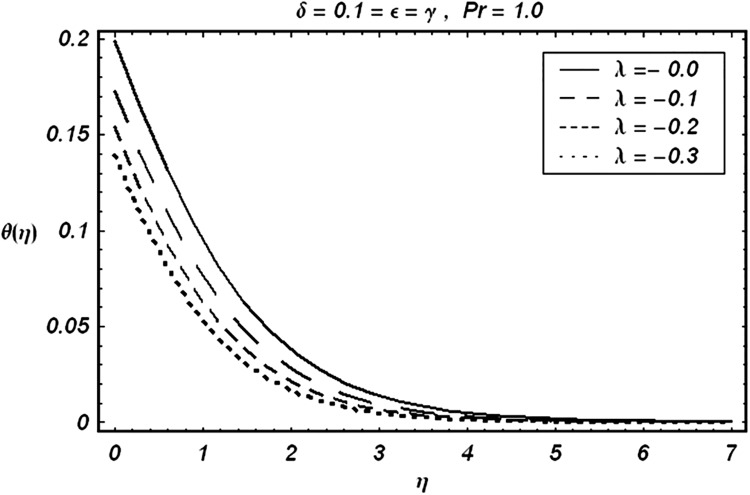
Variation of (λ<0) on θ.